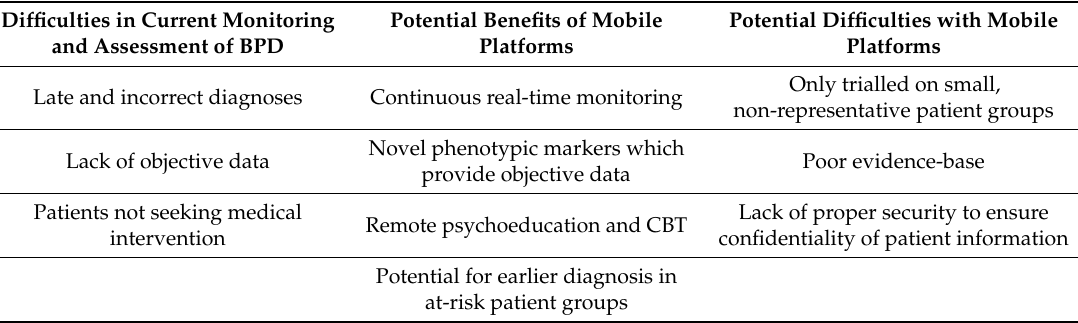
Table 4. Findings of this review on digital platforms for